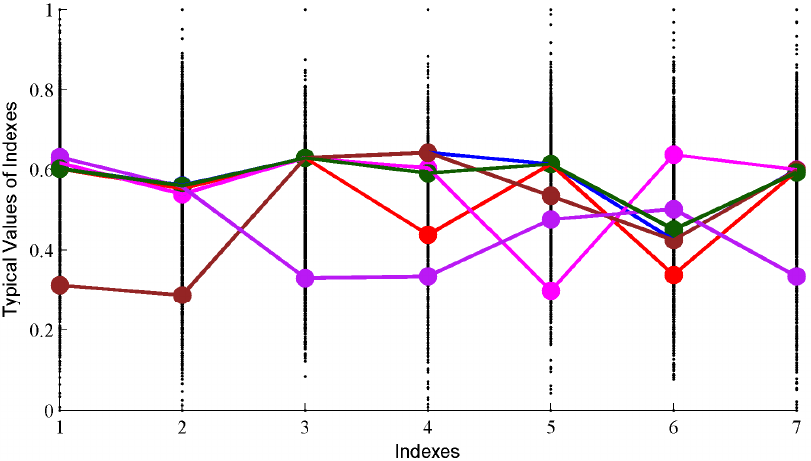
Figure 3. Scatter diagram and Gaussian mixture model (GMM) clustering results of the supplier NB_12.